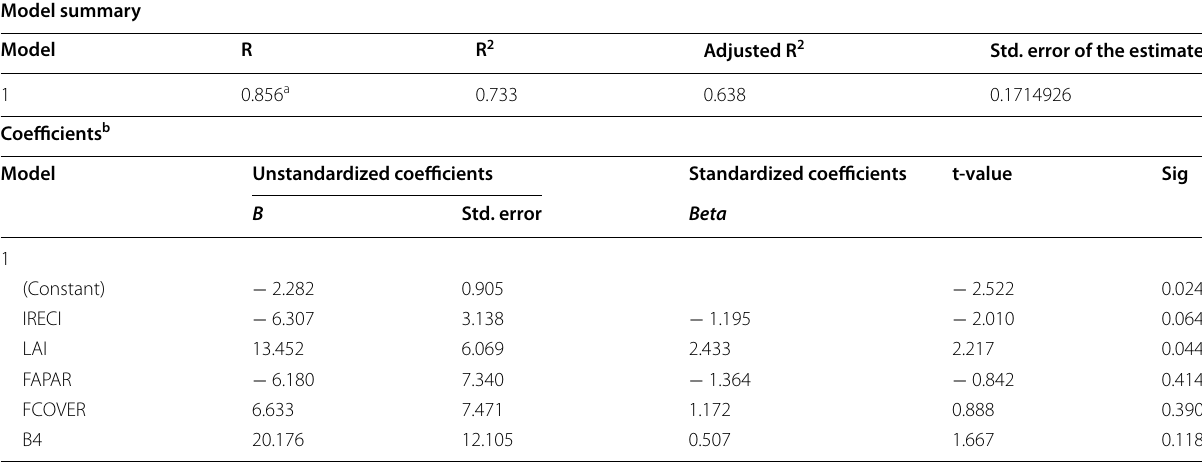
Table 7 Linear regression result of the observed AGB with selected predictor